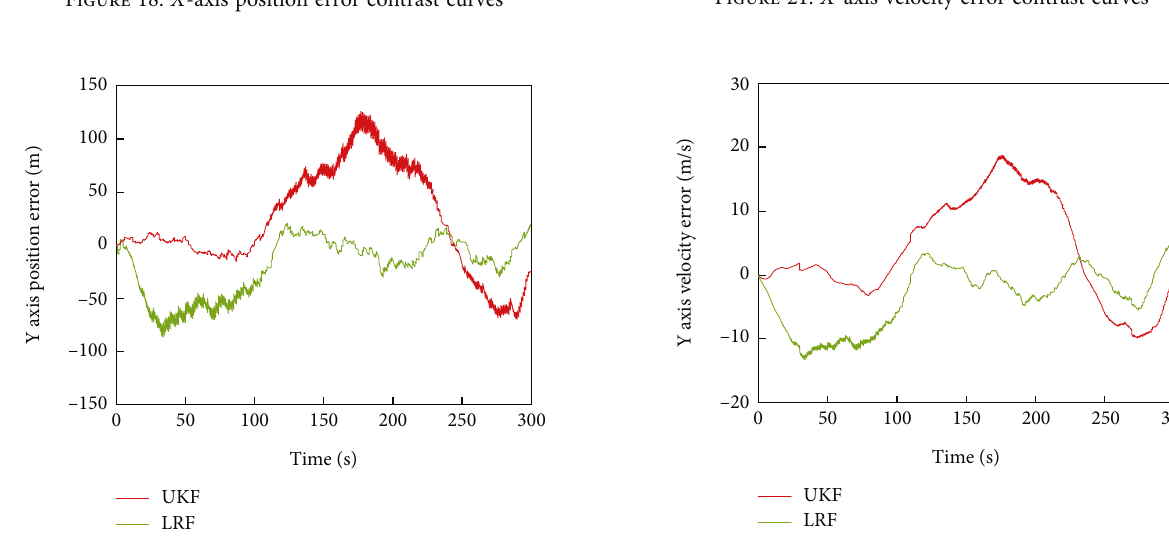
Figure 19: Y -axis position error contrast curves